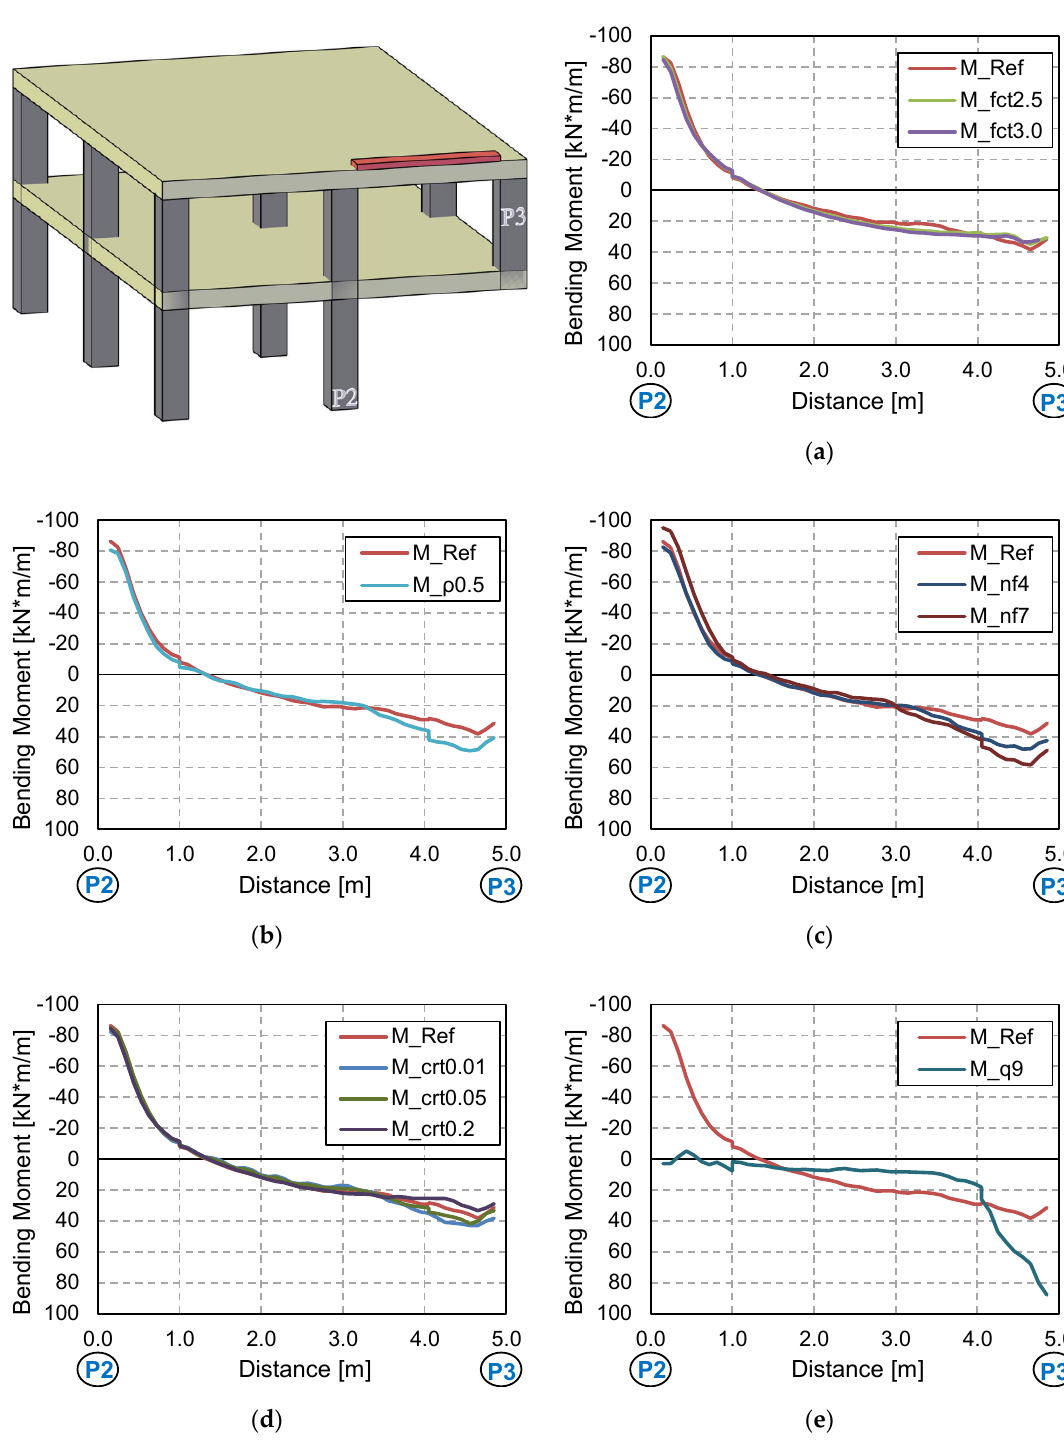
Figure 15. Influence of different parameters on bending moments from P2 to P3 in the second slab: ( a ) tensile strength, ( b ) flexural reinforcement ratio, ( c ) number of floors, ( d ) column removal time, ( e ) superimposed load.